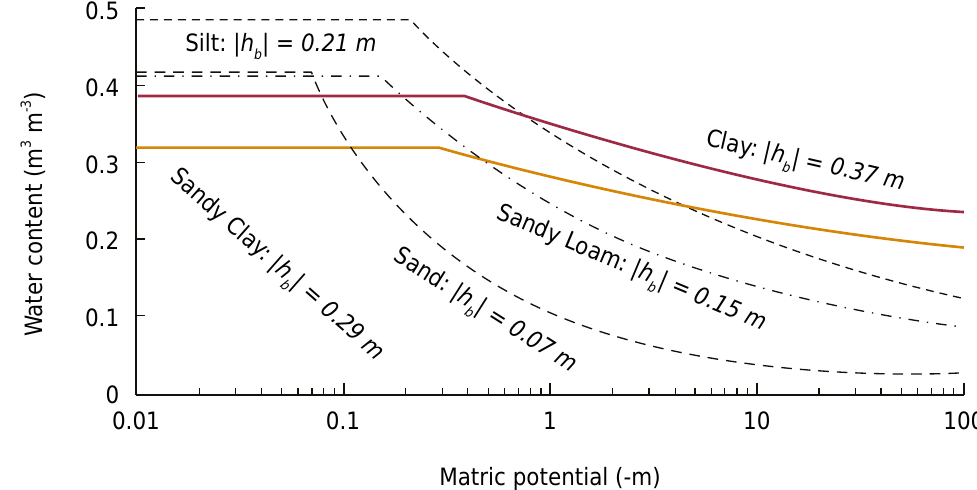
Figure 1. Representative values of | h b | for soils from the Hydrus package (Šimůnek et al.,